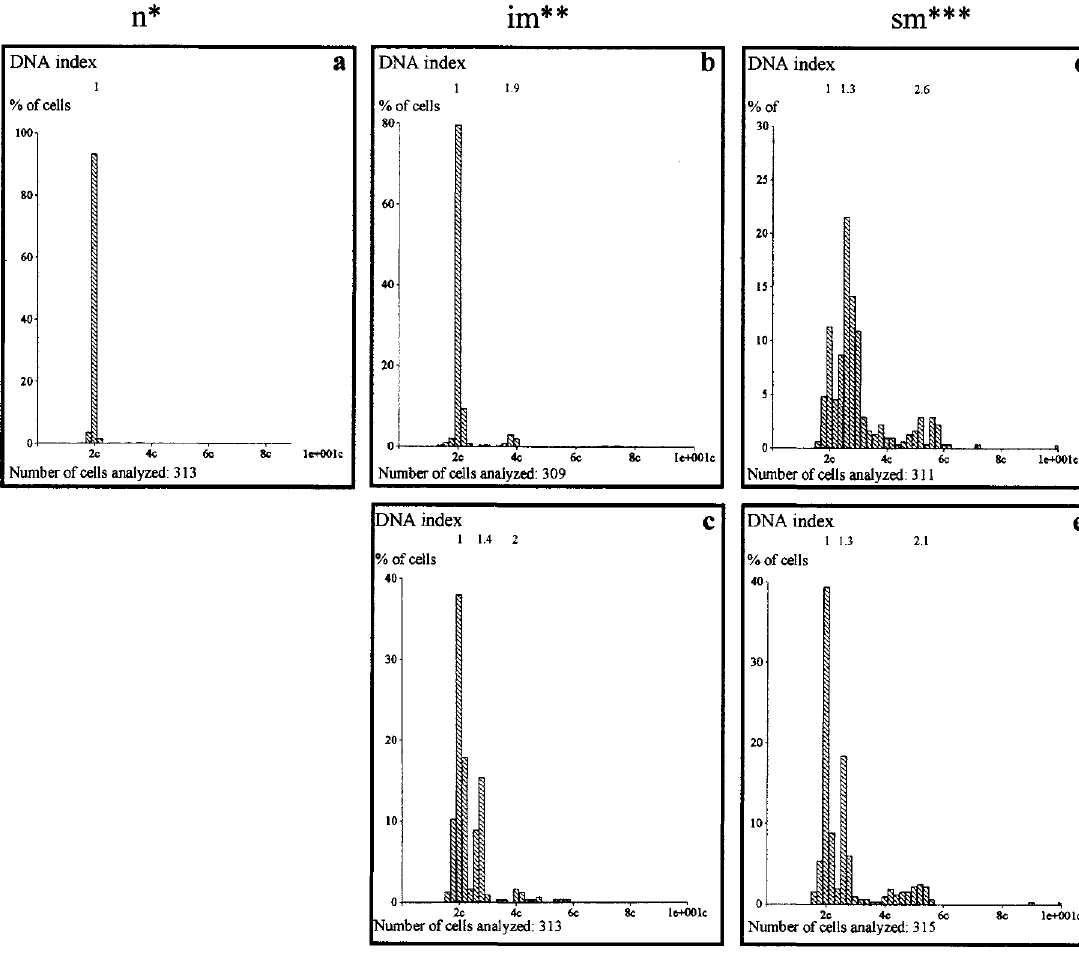
Fig. 2. Histograms illustrating intratumoral DNA-ploidy heterogeneity: *Normal mucosa diploid (a); **intramucosal component showing a diploid (b) and an aneuploid (c) histogram; ***submucosal component ((d) and (e)) showing a variable degree of